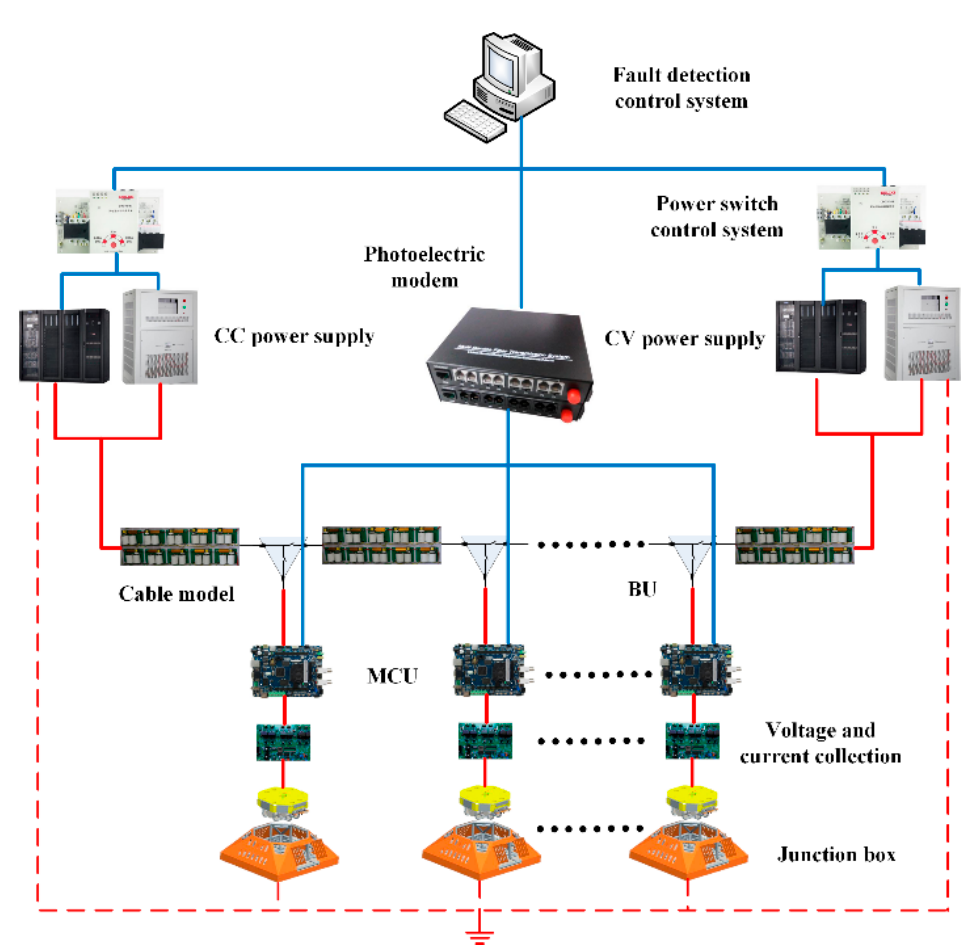
Figure 2. Diagram of fault detection.